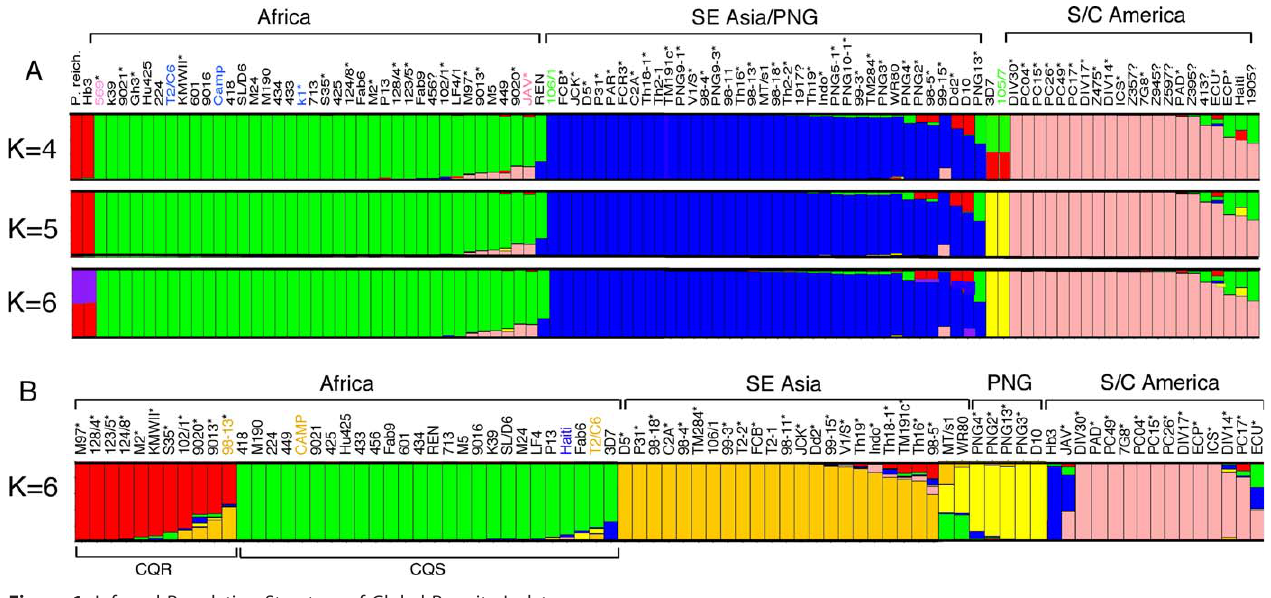
Figure 1. Inferred Population Structure of Global Parasite Isolates Each vertical bar represents an individual parasite with its names given at the top of the panels. Predefined numbers of populations (K ¼ 2–8) were run ten times each, using Structure 2. (A) Population partitions using SNPs from Chromosome 3 (K ¼ 4–6, linkage model). At K ¼ 5, the most consistent membership coefficients were obtained. (B) Population partition using SNPs from 37 putative transporters (admixture model). Similar clustering was obtained with that of Chromosome 3, including Camp and T2/C6 (no data for K1) with African parasites and 106/1 with SE Asian parasites. However, African parasites were partitioned into chloroquine-resistant and -susceptible parasites. Note: Only 81 are available for the transporter data. *, parasites resistant to chloroquine; ?, parasites from which drug data are not available. DOI: 10.1371/journal.pbio.0030335.g001